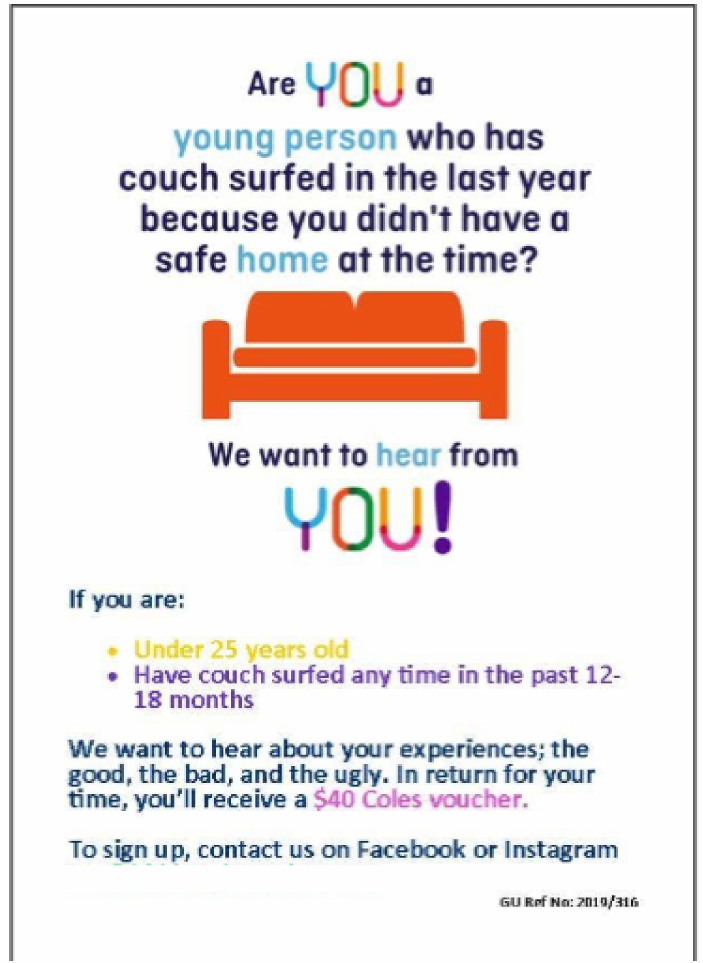
Figure 1. Example of an advertisement run on Facebook and